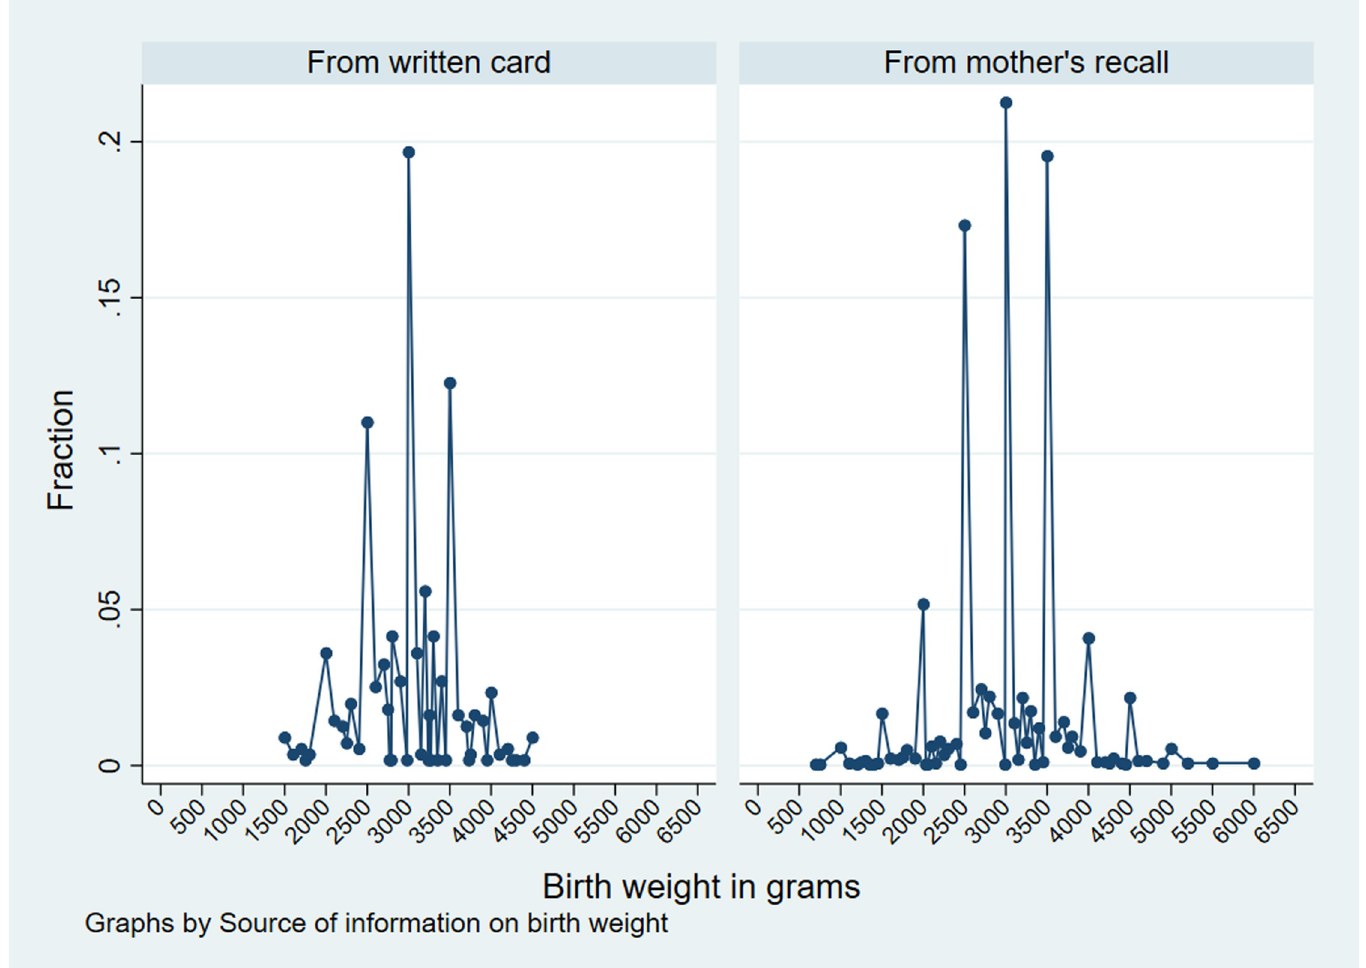
Fig 2. The fraction of newborn children according to their birth weight in grams obtained from written cards and mother’s recall, NDHS 2016.